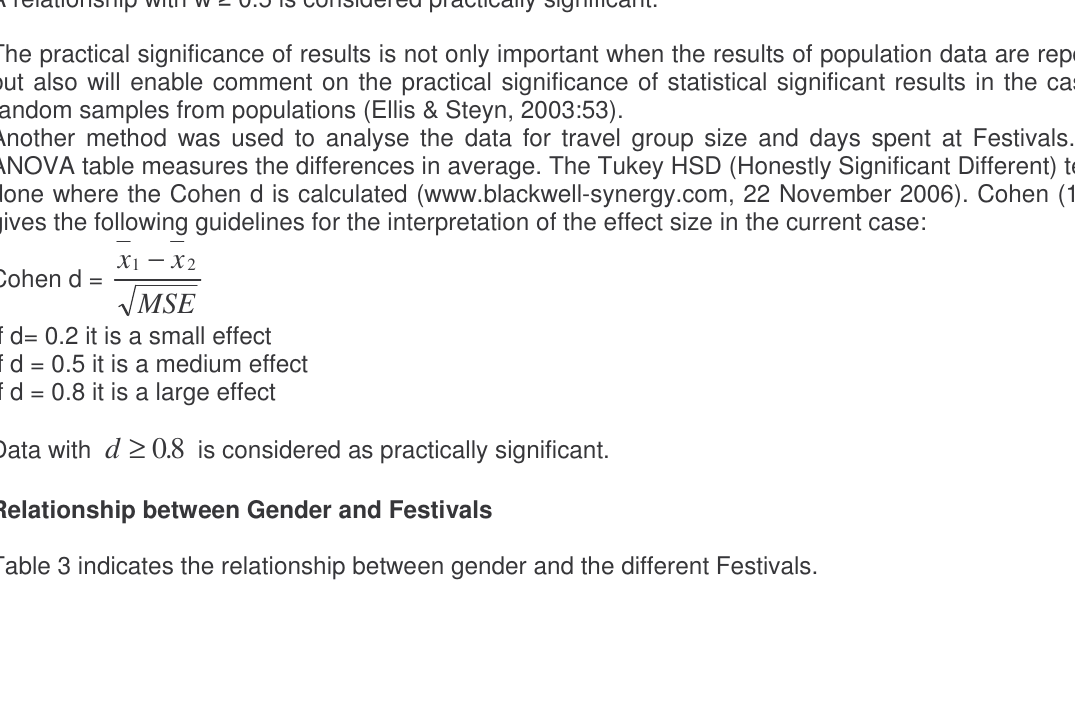
Table 3 indicates the relationship between gender and the different